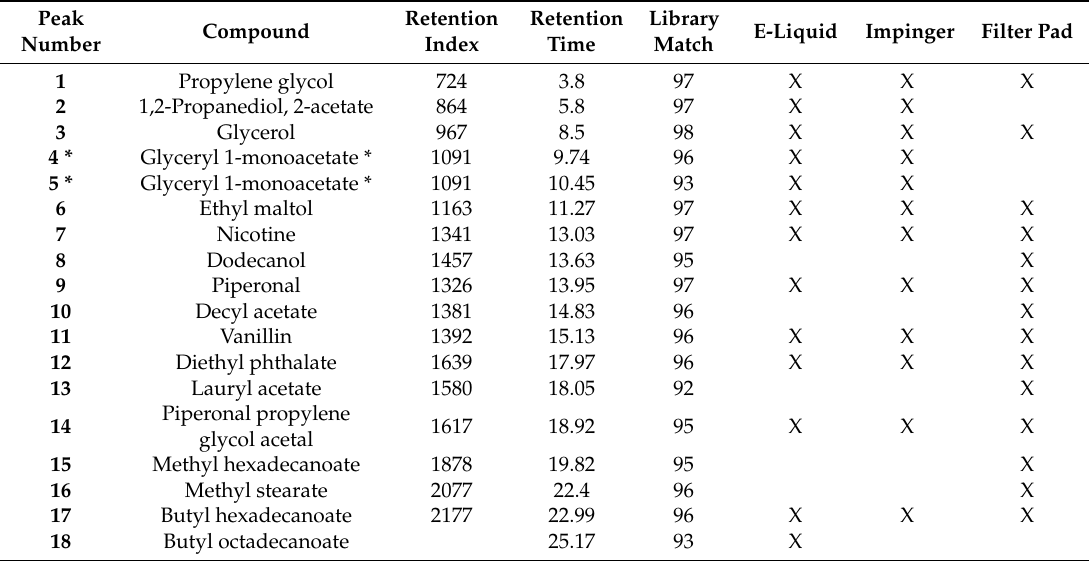
Table 2. GC-MS analysis of molecules in observed in aerosols generated from 100 puffs of vanilla flavor e-liquid, in emissions captured with pads, and methanol